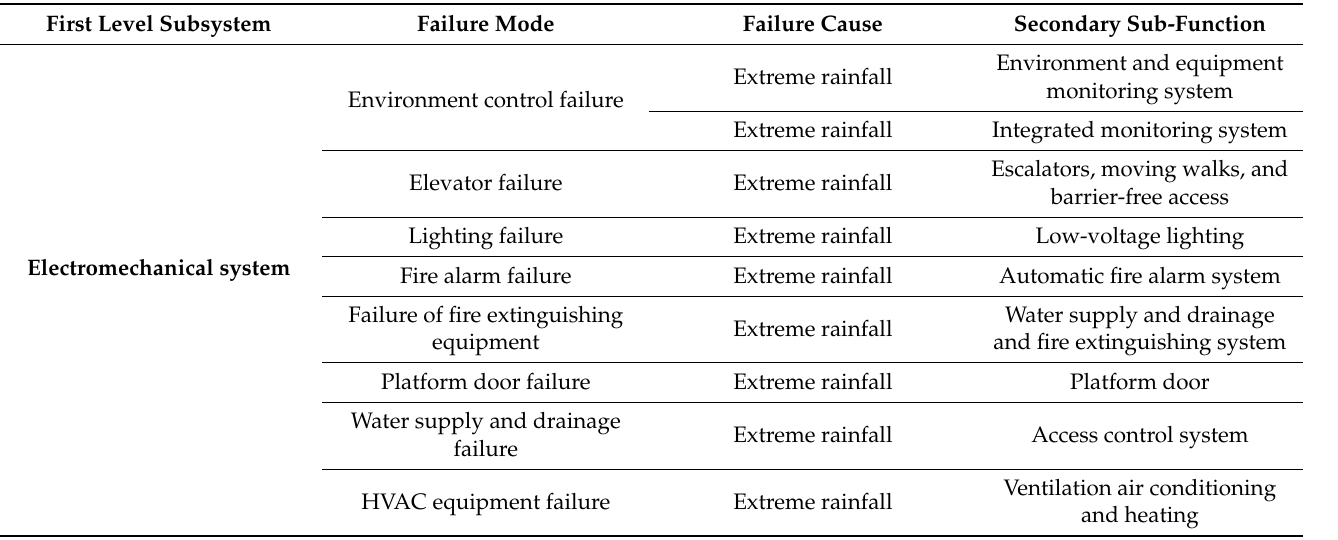
Table 4. The relationship of failure modes, failure causes, and sub-functions of the electromechanical system—examples.